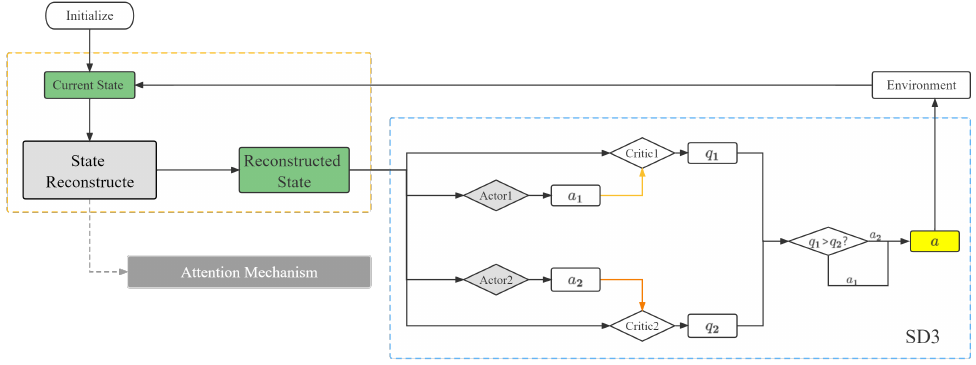
Figure 5. The overall framework for gait adjustment.